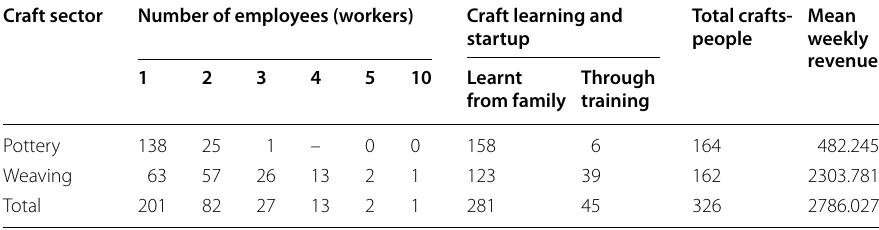
Table 2 Background of each craft sector Craft sector